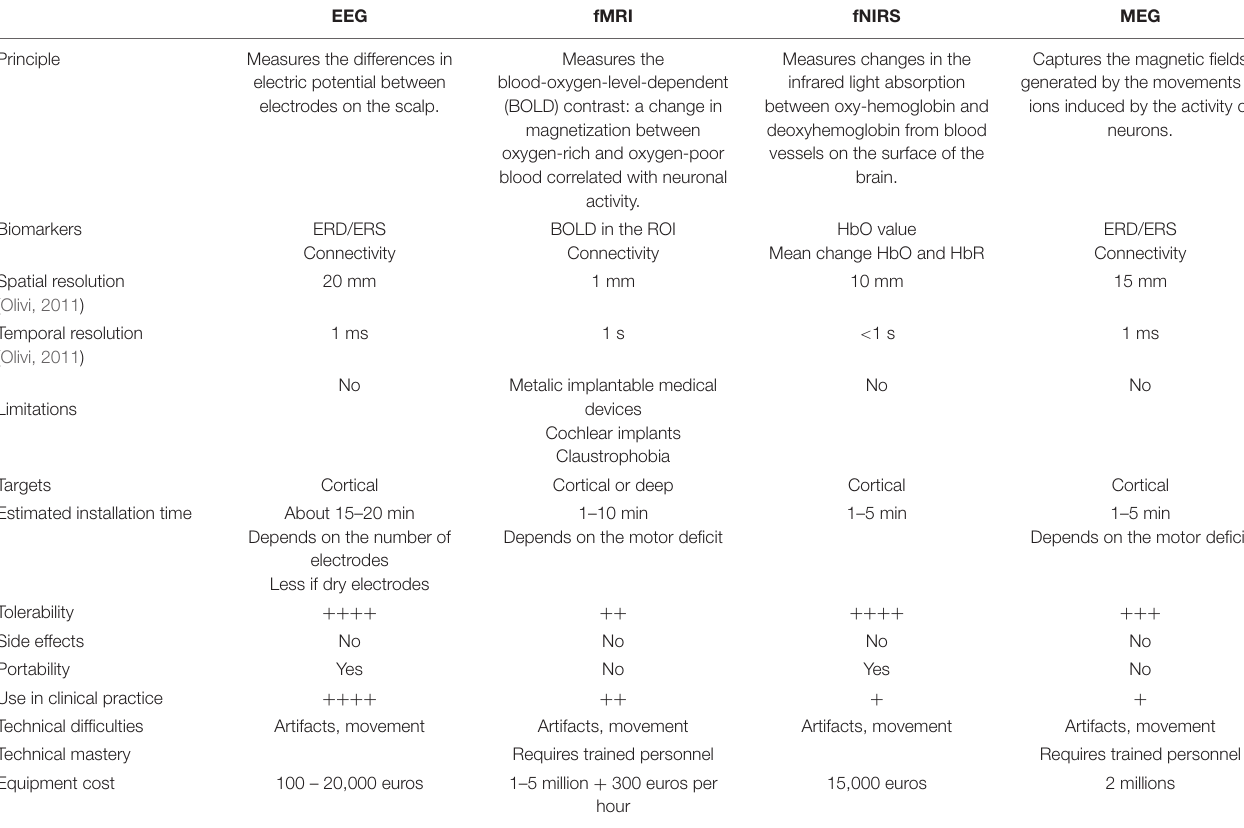
TABLE 1 | Summary of acquisition systems and their specificities used in NFB studies in post-stroke context. EEG fMRI fNIRS MEG Principle electrodes on the scalp. (BOLD) contrast: a change in between oxy-hemoglobin and magnetization between deoxyhemoglobin from blood oxygen-rich and oxygen-poor vessels on the surface of the blood correlated with neuronal activity.